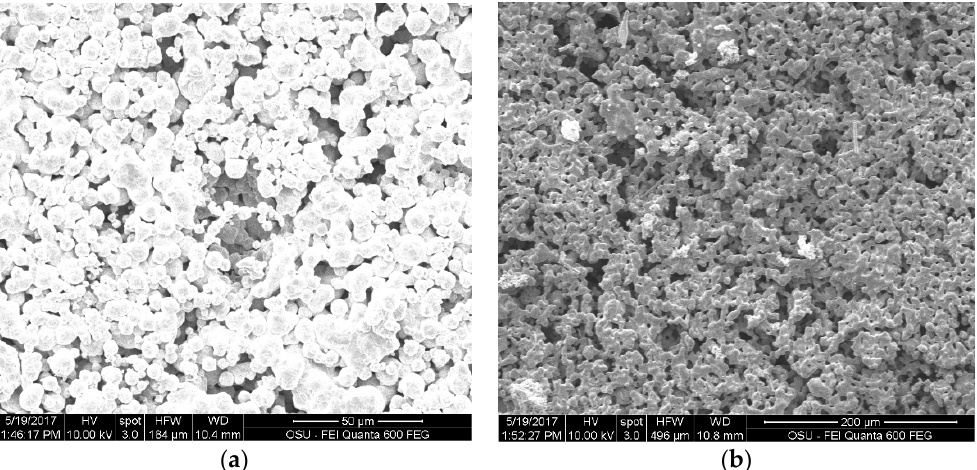
Figure 12. SEM images from ( a ) before reaction; and ( b ) after reaction. Note that magnification scales are